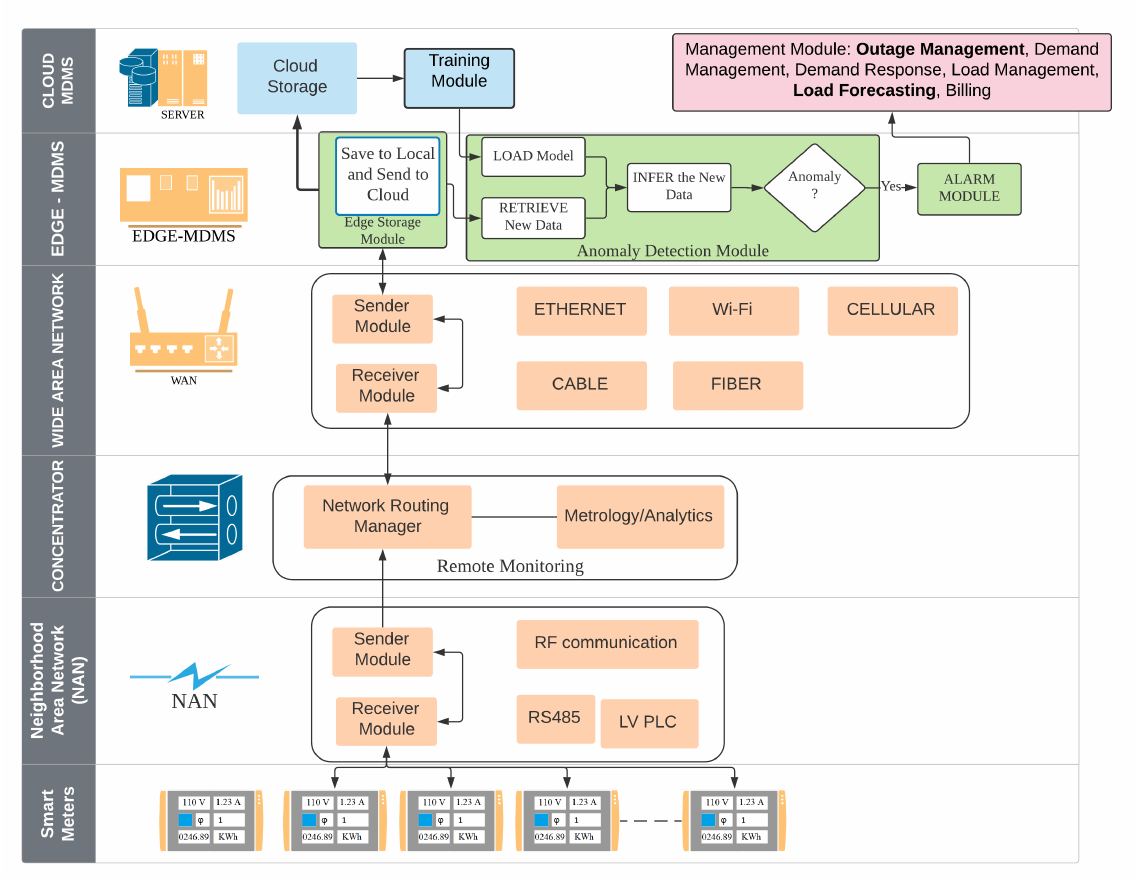
Figure 2. Anomaly Detection System